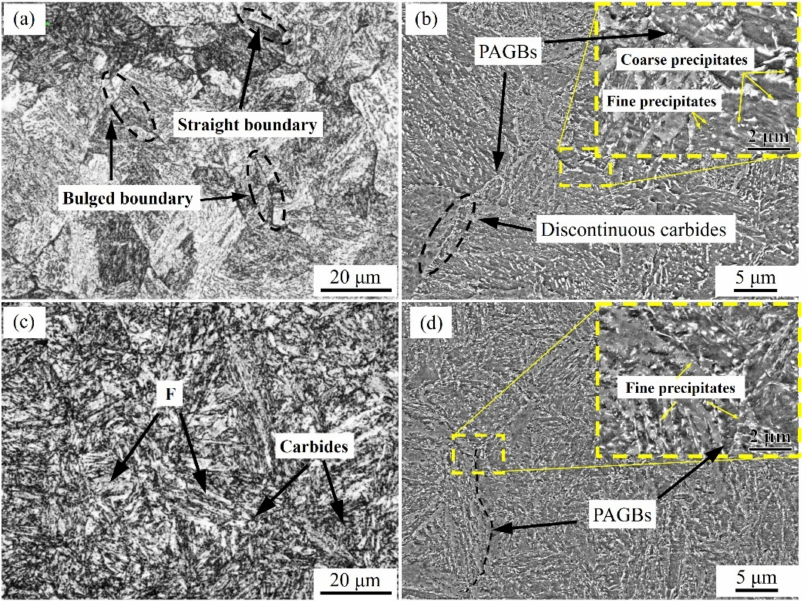
Figure 3. OM and SEM images of ( a , b ) NT and ( c , d ) QT. The tallow dashed box in the upper right corner of ( b , d ) is a partially enlarged detail image. PAGBs: prior austenite grain